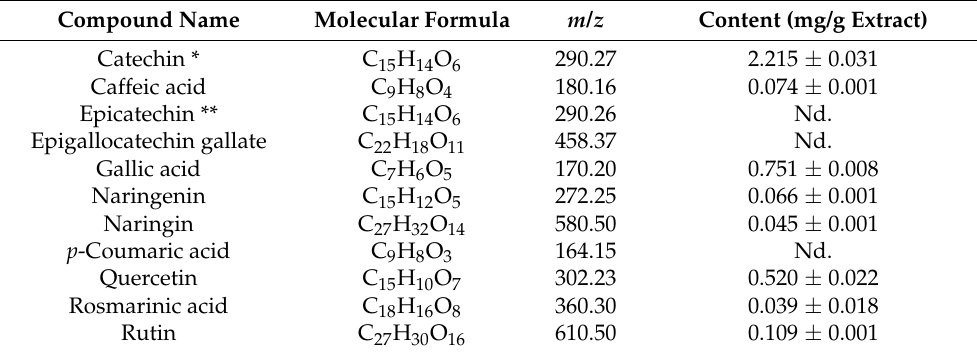
Table 1. Liquid chromatography–mass spectrometry data of compounds detected in Psidium guajava leaf